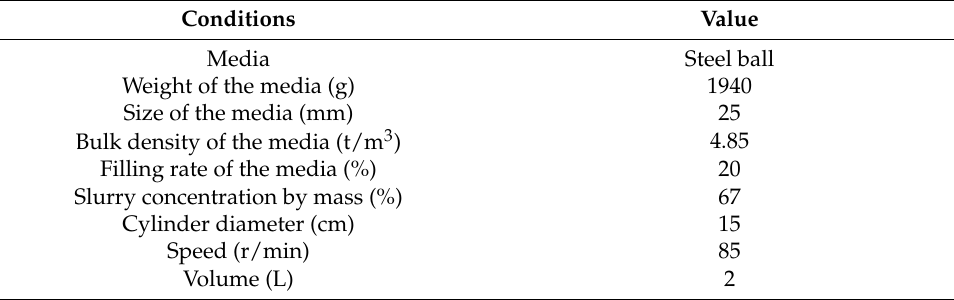
Table 2. The operating conditions of the grinding